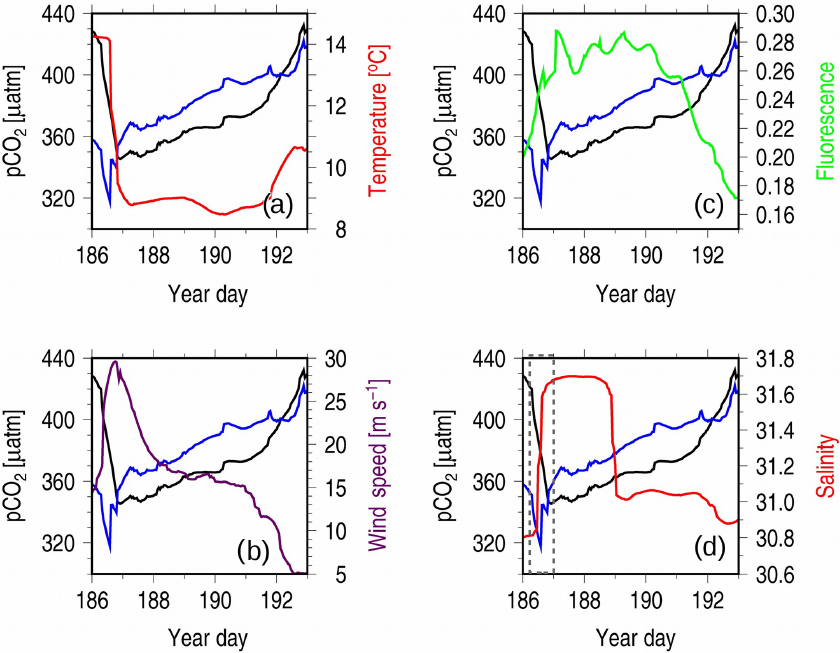
Figure 6. Observations during Hurricane Arthur taken from the CARIOCA 2014 dataset, with the x axis representing year days. Each panel has p CO 2 in black (µatm) and p CO 2 ( T mean ; µatm) in blue, with a different variable in each panel overlain: (a) temperature, (b) wind speed,